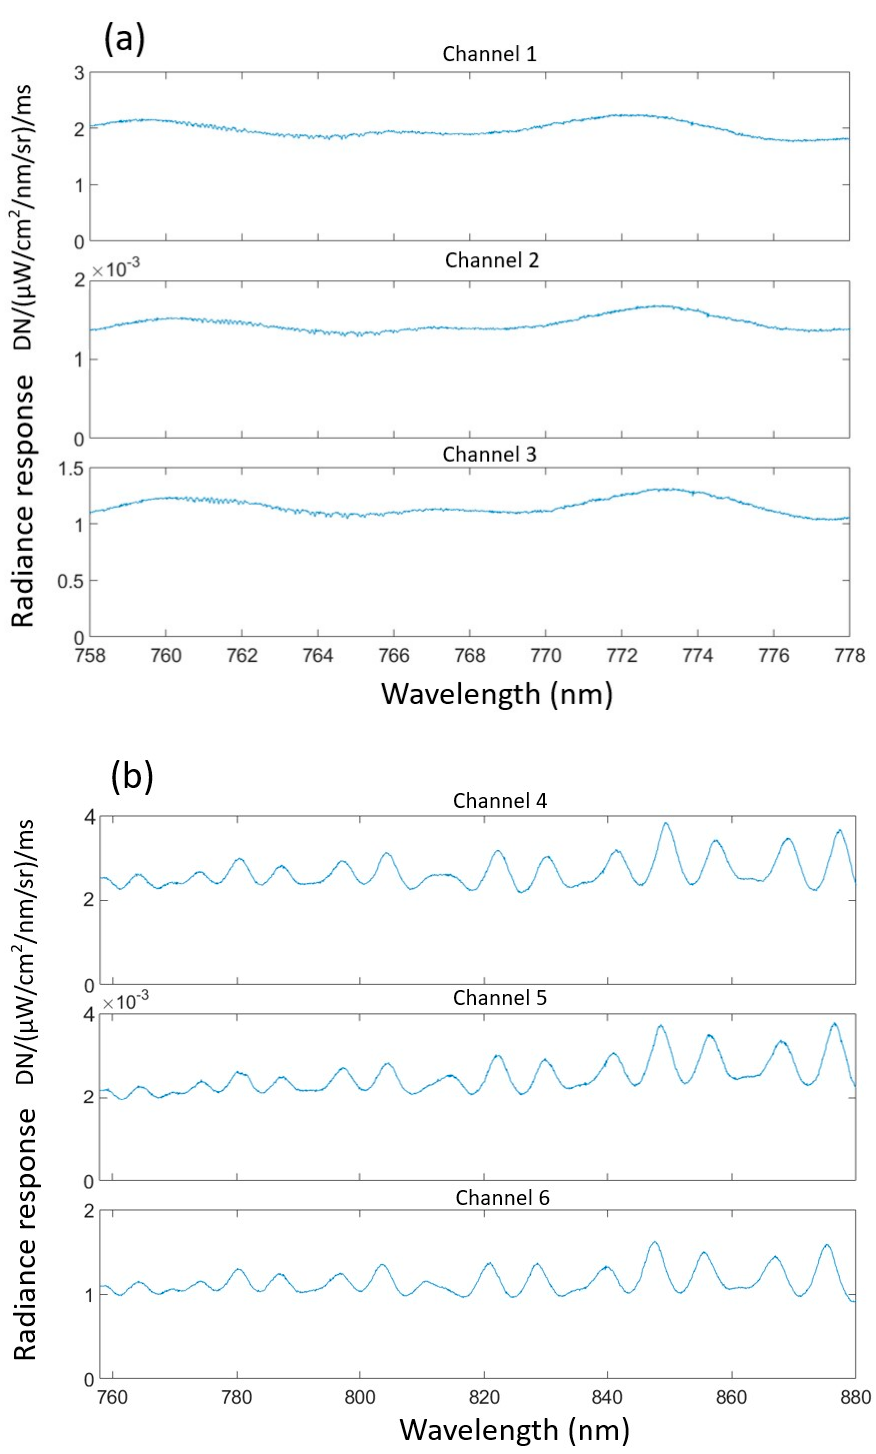
Figure 25. The fitting curve between the radiation response test results in the laboratory and the filter transmittance test results: ( a ) Molecular oxygen A ‐ band (758–778 nm); ( b ) Water vapor ab ‐ transmittance test results: ( a ) Molecular oxygen A-band (758–778 nm); ( b ) Water vapor absorption sorption band (758–880 nm). band (758–880